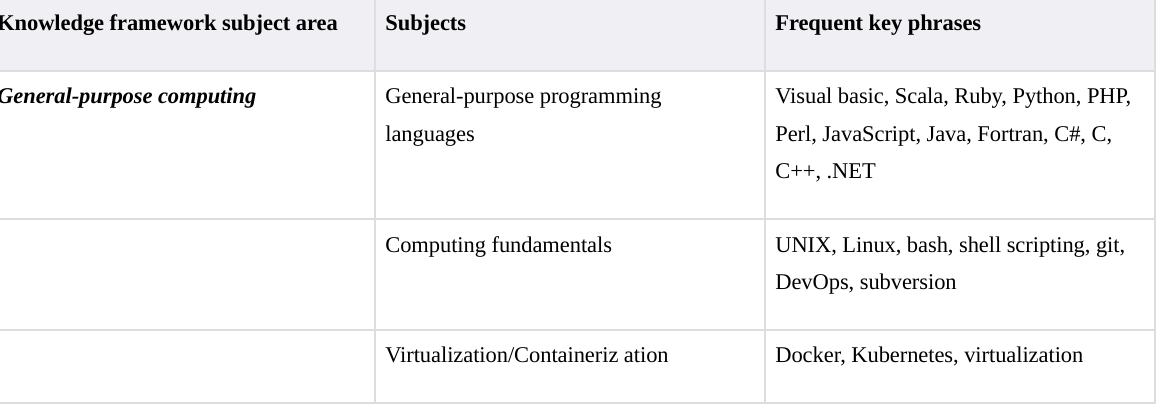
Table B1. LinkedIn key